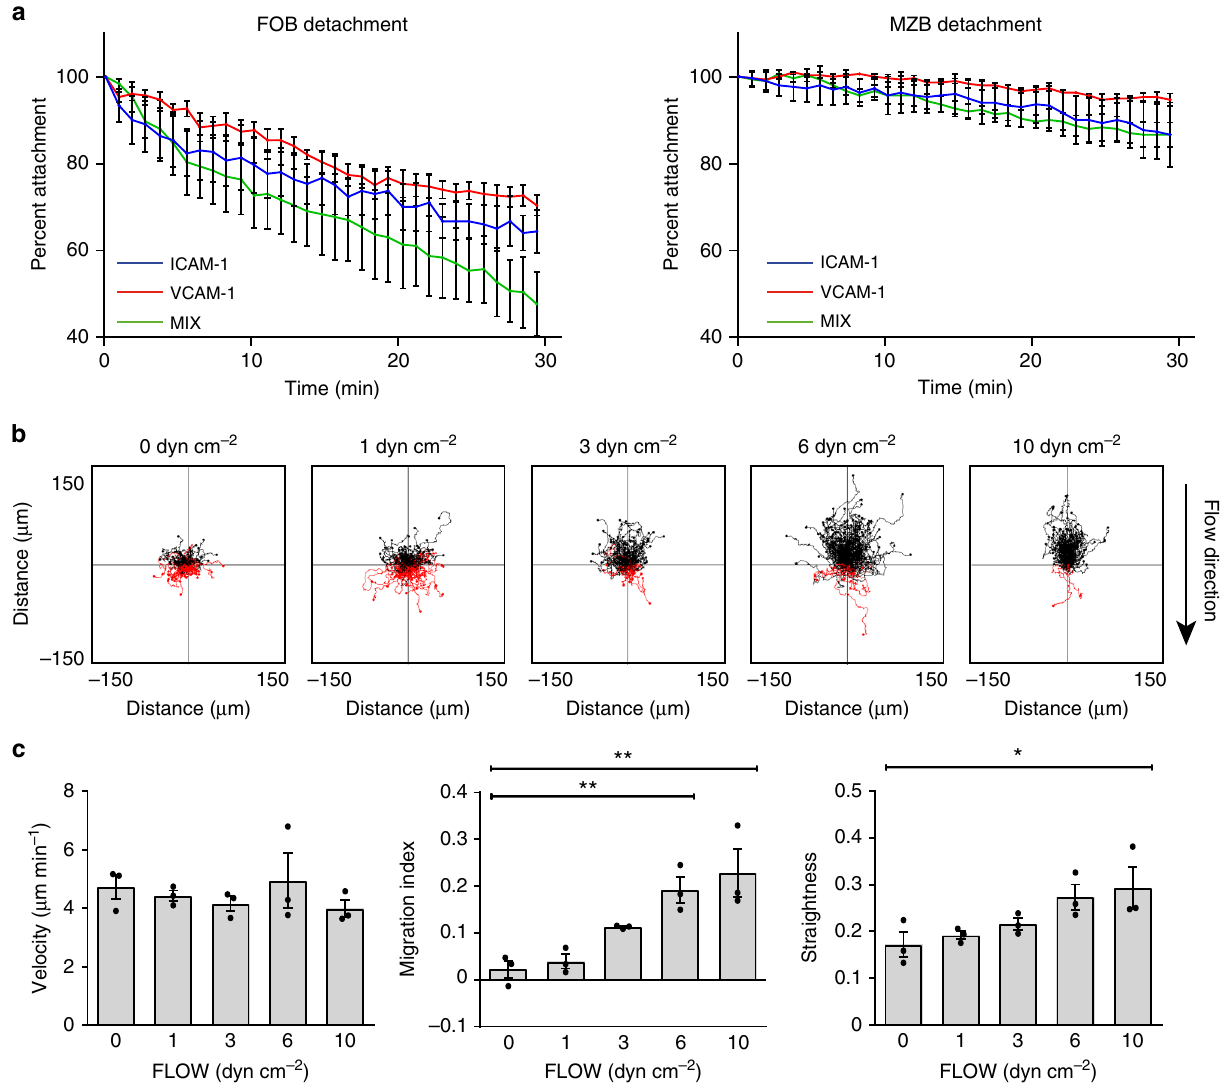
Fig. 1 MZB are not fl ushed out by shear fl ow but migrate up it. a Detachment over time of marginal zone B cells (MZB) and follicular B cells (FOB). Percent attachment based on number of cells after fl ow (3 dyn cm − 2 ) start ( t = 10 s), mean ± SEM on ICAM-1 (2 µ g ml − 1 ), VCAM-1 (2 µ g ml − 1 ), or ICAM-1 and VCAM-1 (1 µ g ml − 1 each) mixed ( n = 3). b Representative track plots of MZB migration up the fl ow on ICAM-1 (7 µ g ml − 1 ). Flow strengths indicated in dyn cm − 2 by the number over the track plot; fl ow direction indicated by arrow. Tracks with end points above the horizontal axis are shown in black; tracks below are shown in red. c Quanti fi cation of velocity, migration index, and straightness for the indicated fl ow strengths. All three graphs show different parameters from the same set of experiments; bars show mean ± SEM. Data are from three experiments with 1 mouse each. Symbols in one condition group denote the three replicates and represent the average of 100 – 200 cells from each individual mouse. * P < 0.05, ** P < 0.01, one-way ANOVA with Dunnett post hoc tests comparing all fl ow strengths to 0 dyn cm −